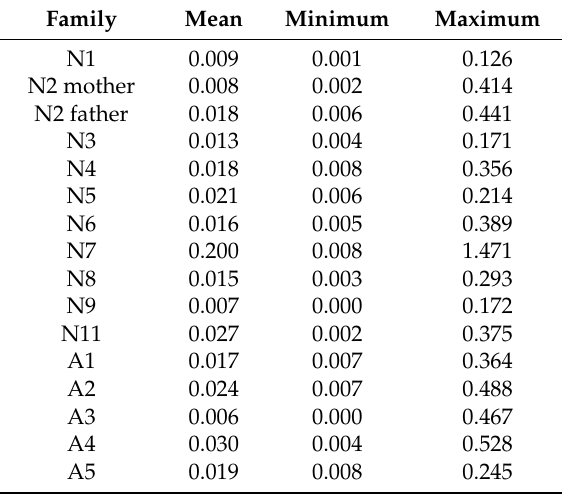
Table 1. Mean, minimum and maximum PM 2.5 readings for each participating family at baseline ( µ g/m 3